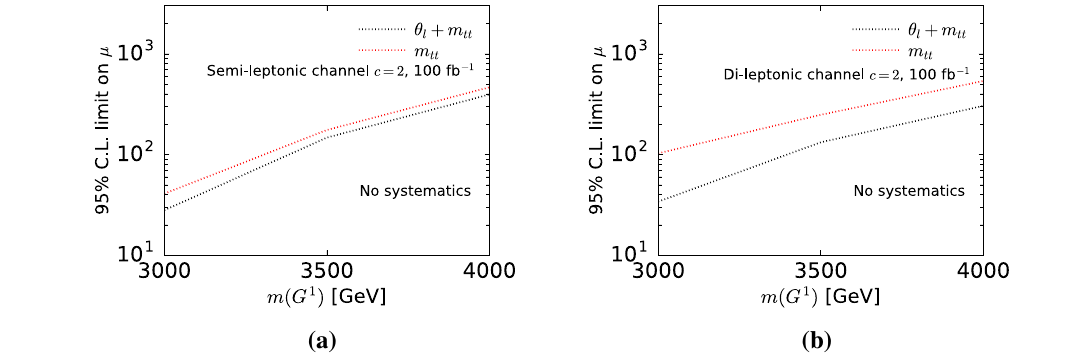
Fig. 8 Limits on μ for a wide ( c = 2) G 1 using the semi-leptonic ( a ) and di-leptonic ( b ) analyses for a fixed luminosity of 100 fb − 1 with no systematics as a function of resonance mass using m ( t ¯ t ) and cos θ l ±